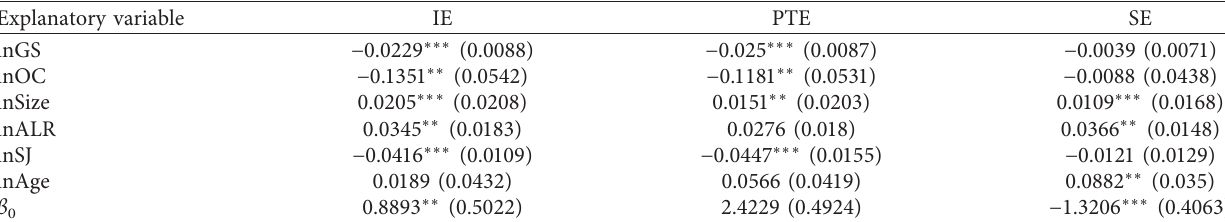
Table 5: Panel regression